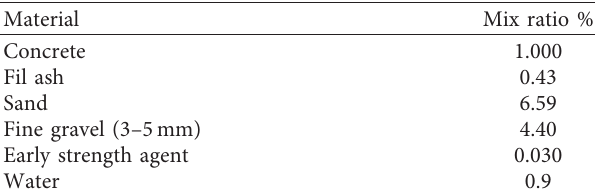
Table 3: Mix ratio of model fine aggregate